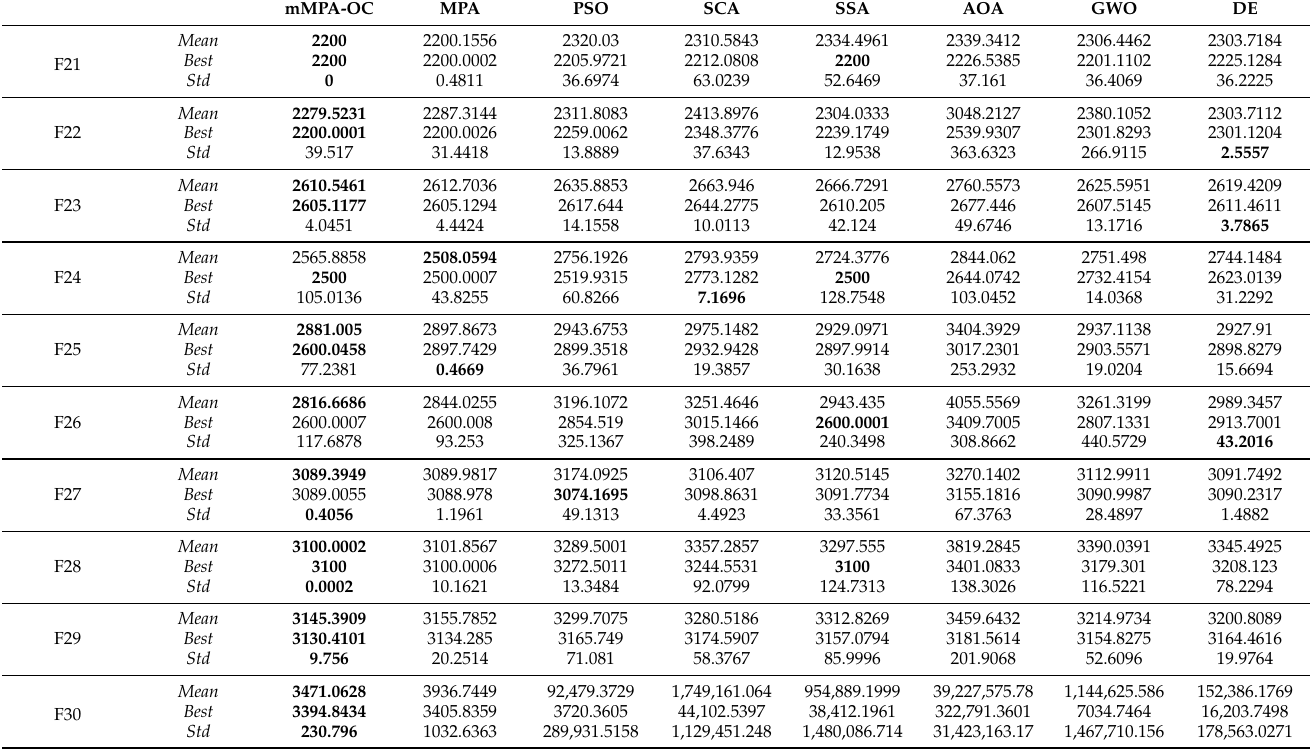
Table 5. Comparison of experimental results on CEC-2017 (10-dimensions) combined